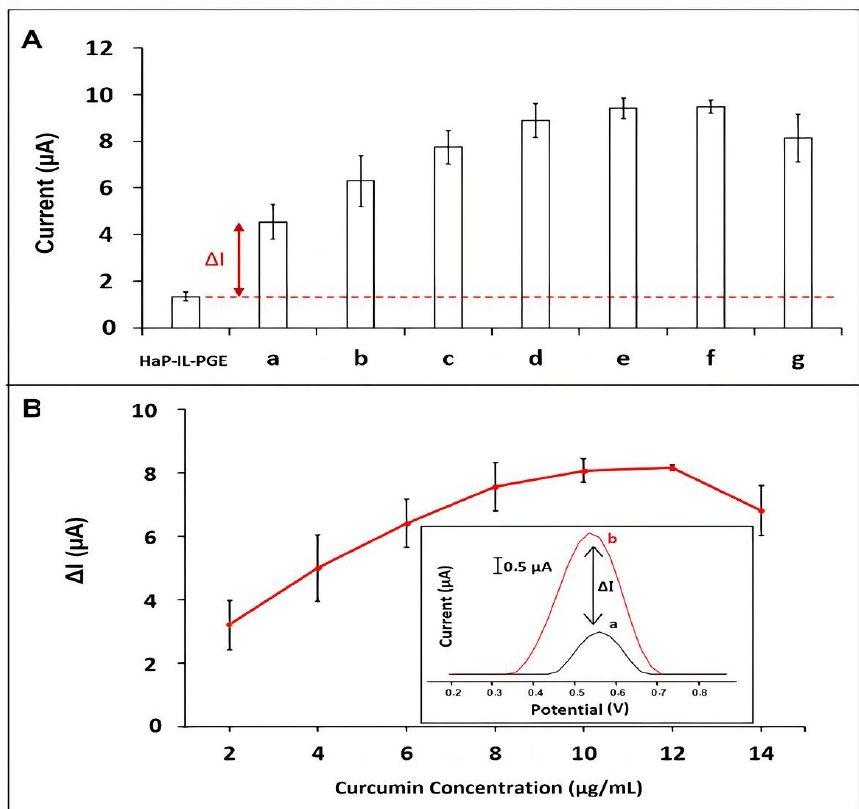
Figure 4. ( A ) Histograms related to the average curcumin oxidation signals ( n = 9) recorded in the presence of (a) 2, (b) 4, (c) 6, (d) 8, (e) 10, (f) 12 and (g) 14 µ g/mL curcumin onto the HaP-IL-PGEs; ( B ) the line graphs illustrate the curcumin oxidation signal obtained in the presence of various Curcumin concentrations from 2 to 14 µ g/mL by using HaP-IL-PGE. Inset: (a) signal measured in ABS buffer in control experiment at + 0.56 V peak potential by HaP-IL-PGE; (b) signal measured in ABS buffer at + 0.56 V peak potential after curcumin immobilization.